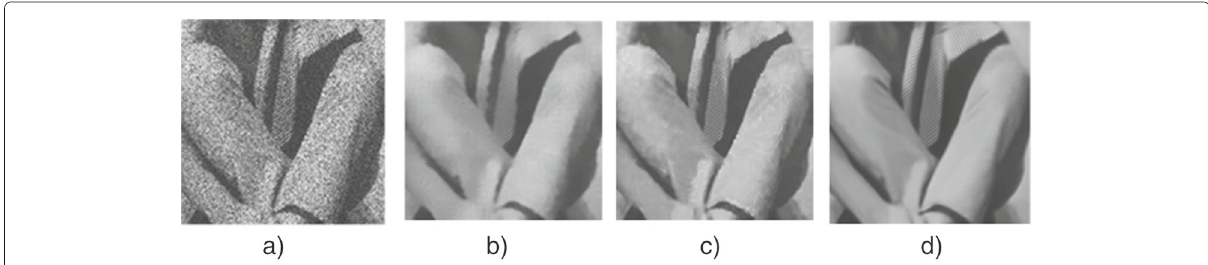
Fig. 8 Despeckling for spatial complicated SAR image scene. a Noisy: 1-look; PSNR = − 0.1042; SSIM = 0.21. b PPB despeckling: PSNR = 7.8943; SSIM = 0.63. c SAR-BM3D despeckling: PSNR = 9.9312; SSIM = 0.73. d 3SD-based despeckling: PSNR = 10.3316; SSIM =